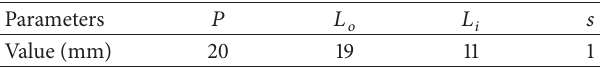
Table 1: Parameters of the optimized AMC